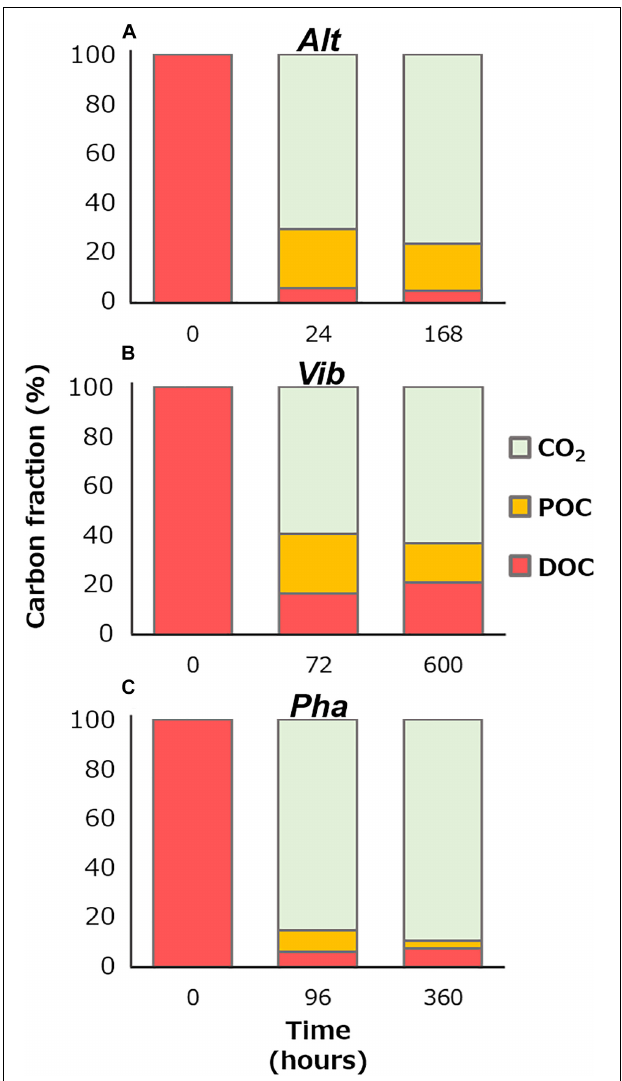
FIGURE 5 | Percentage of carbon species at the initiation of the incubation, the initiation of the stationary phase, and the end of the incubation of the Alt (A) , Vib (B) , and Pha (C) . The amount of remineralization into carbon dioxide was calculated from decreases in TOC concentration from the initiation of the incubation.